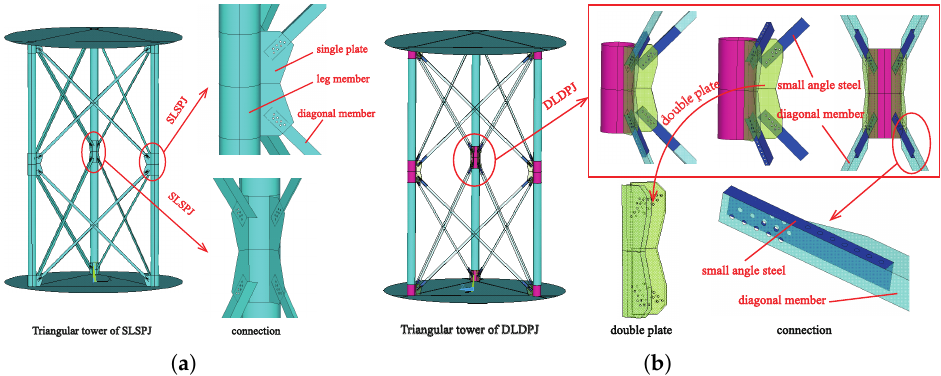
Figure 8. ( a ) The geometric model of triangular tower with the SLSPJ. ( b ) The geometric model of triangular tower with the DLDPJ.